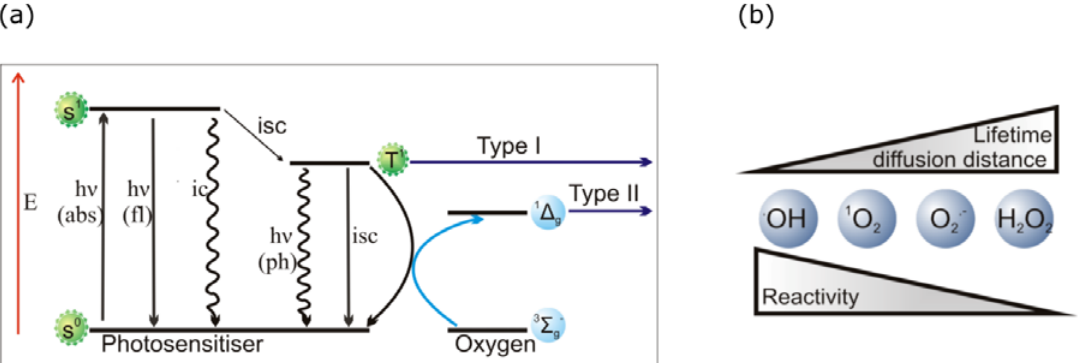
Figure 4. Photophysical PS mechanisms. ( A ) A Simplified Jablonski diagram showing the energy transfers involved in PDT . S 0 is the PS-drug ground state, S 1 is the PS-drug in an unstable excited state, T 1 is the PS-drug’s triplet excited state which can react with either − ) to produce singlet oxygen ( 1 Δ ) (type II reaction) or molecular ground state oxygen ( 3 Σ g g react with other substrates (type I reaction). h ν denotes photon/ energy; abs: absorption; fl: fluorescence; ic: internal conversion; ph: phosphorescence; isc: intersystem crossing [35,50]. ( B ) Schematic comparison of the reactivity , lifetime and diffusion distance of the main cytotoxic species in PDT. Reproduced from